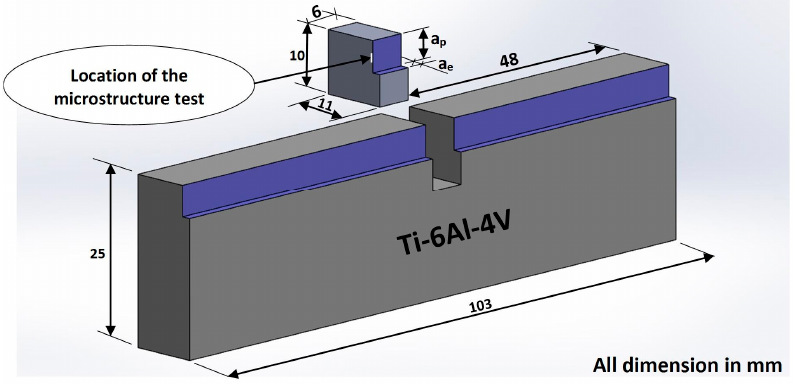
Figure 6. Cut-out of Ti-6Al-4V sample for surface microstructure testing.